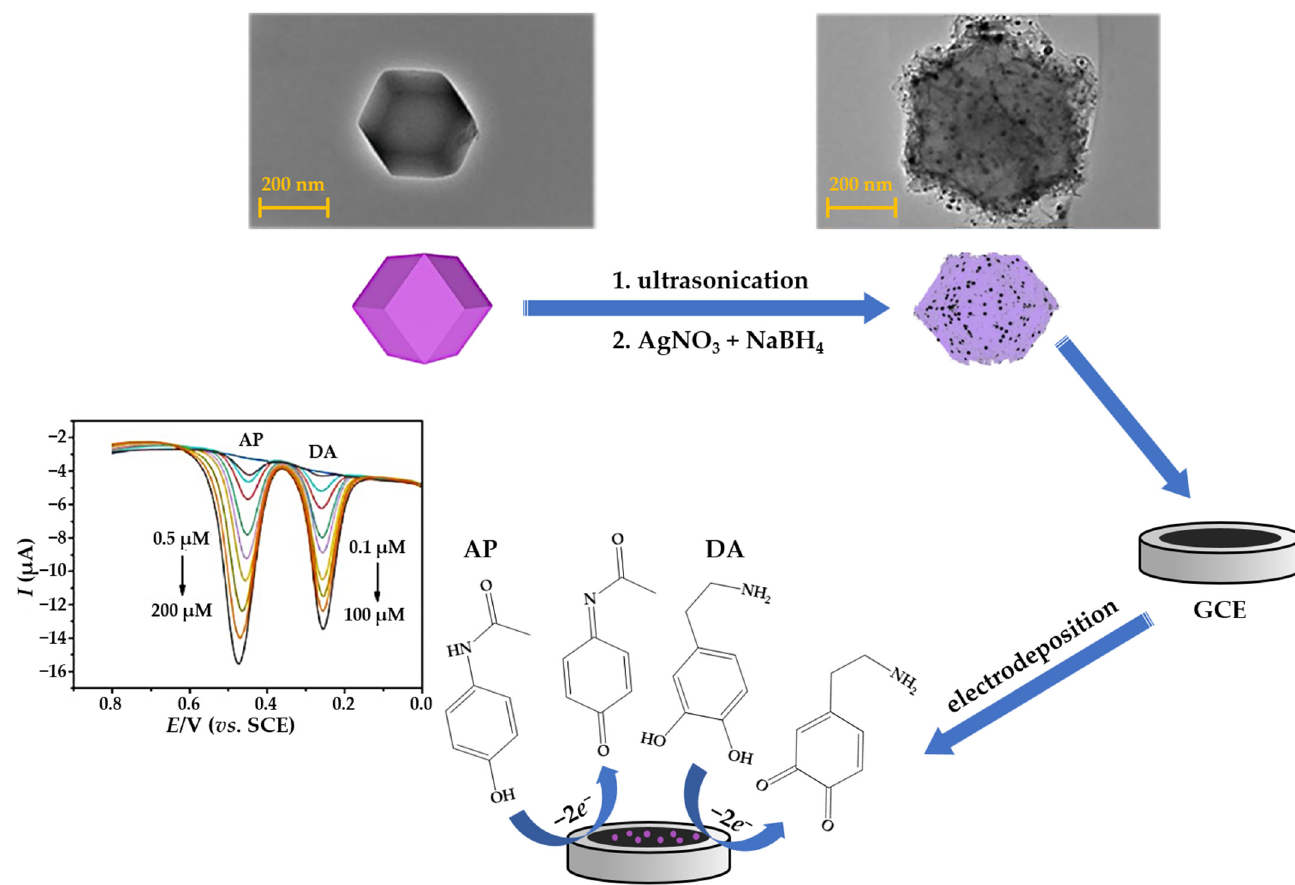
Figure 9. Schematic presentation of the nanosiler-based nanopinnas composite material (Ag-ZIF-67p) DPV sensor for the selective detection of acetaminophen (AP) and dopamine (DA) on the surface of the glassy carbon electrode. Reproduced with permission from ref. [165]. Copyright 2022 Elsevier.